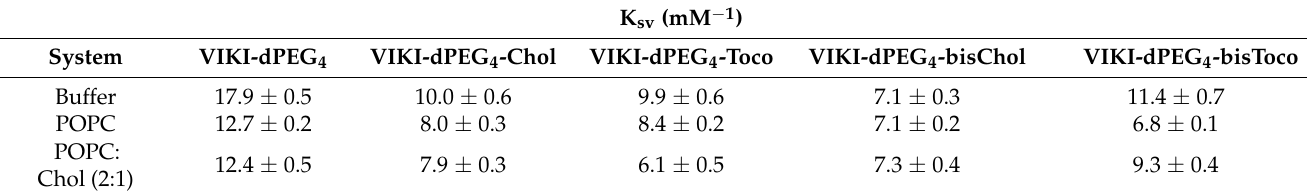
Table 1. Quenching of VIKI peptides by acrylamide in the absence (buffer) and presence of lipid vesicles. LUV of POPC and POPC:Chol were used at a lipid concentration of 0.5 mM. The Stern– Volmer constants (mM − 1 ) were obtained by fitting Equation (3) to the experimental data. Data are presented as mean values ± standard error (SE) from three independent experiments.